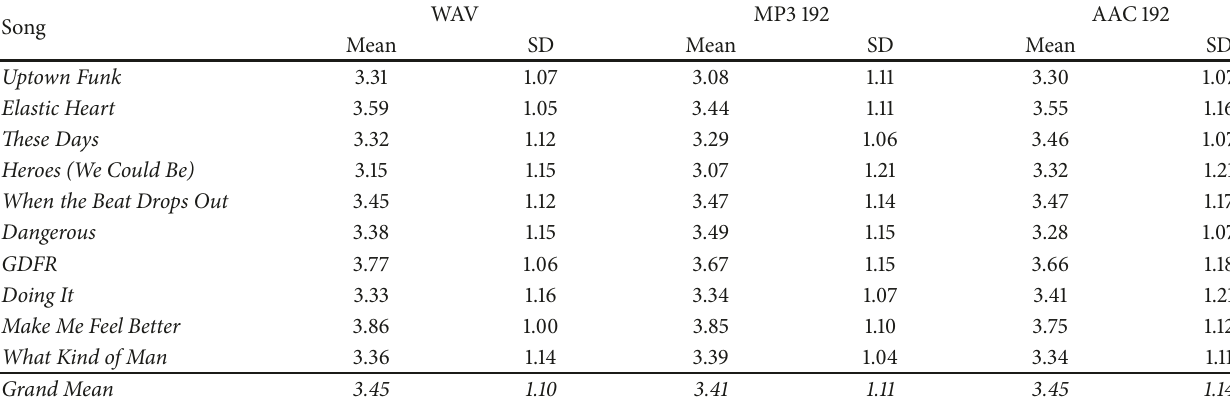
Table 6: Summary stereo image scores: WAV, MP3 192, and AAC 192 (n=63). A score of 1 represents narrow and imprecise and a score of 5 represents wide and precise noise and distortions.